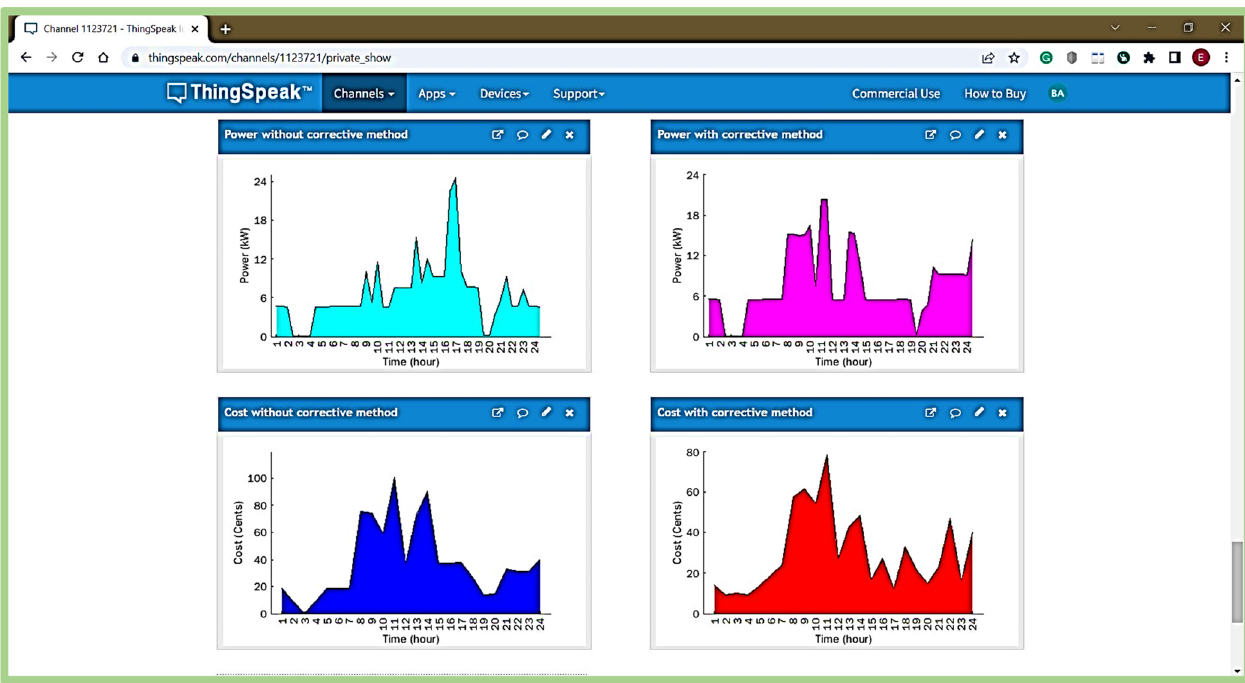
Figure 9. User interface design platform.